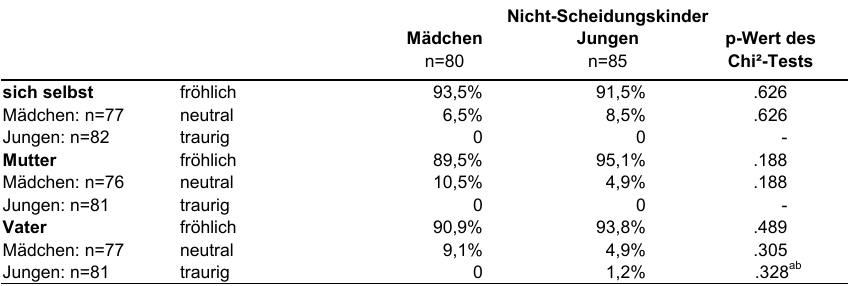
Tabelle 9: Mimik der abgebildeten Figuren (Nicht-Scheidungskinder